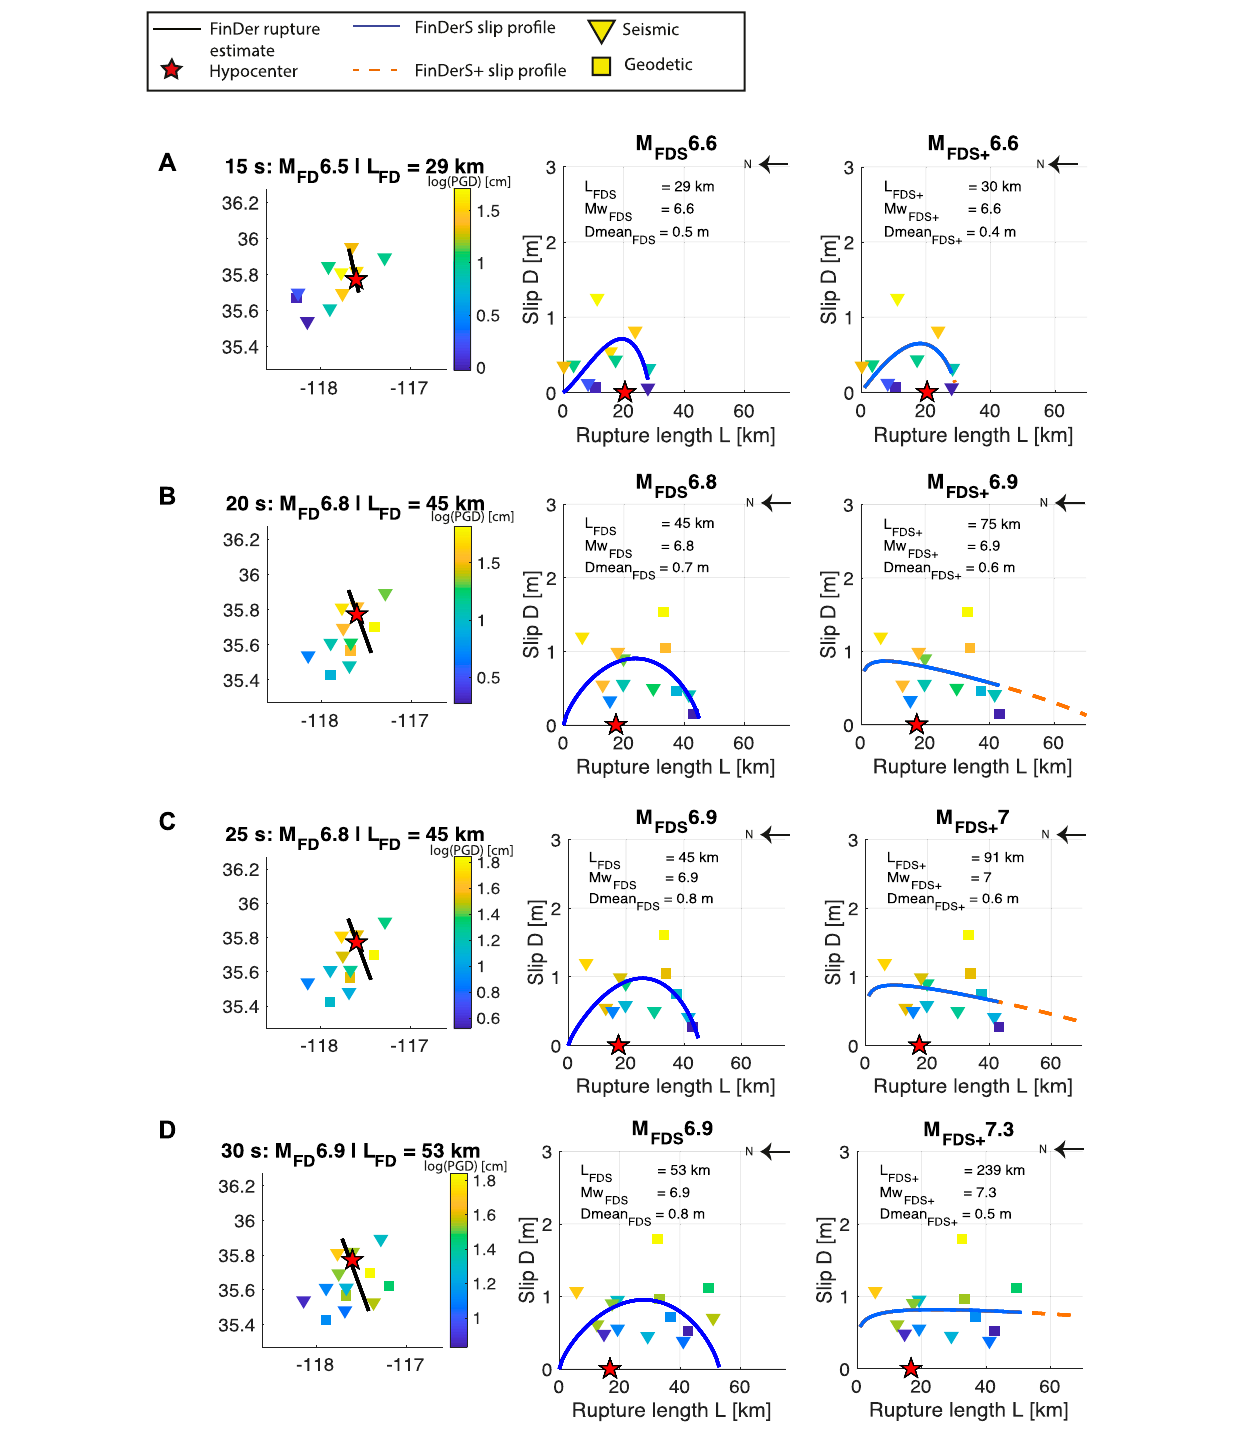
FIGURE 5 | Playback results for the M W 7.1 Ridgecrest earthquake (L ∼ 50 km, ∼ 20 s rupture duration) at a) 15 s, b) 20 s, c) 25 s, and d) 30 s from event origin. Plots ontheleftshow FinDerline-source(blackline)andPGD measurements at seismic(triangles) and geodetic (squares) sensors. Plots inthemiddleshowinterpolated slip pro fi les from FinDerS. Plots on the right show predicted slip pro fi les from FinDerS+. Epicenters are relative to the respective FinDer line-source model, oriented as indicated on the plots. See Table 2 for details.